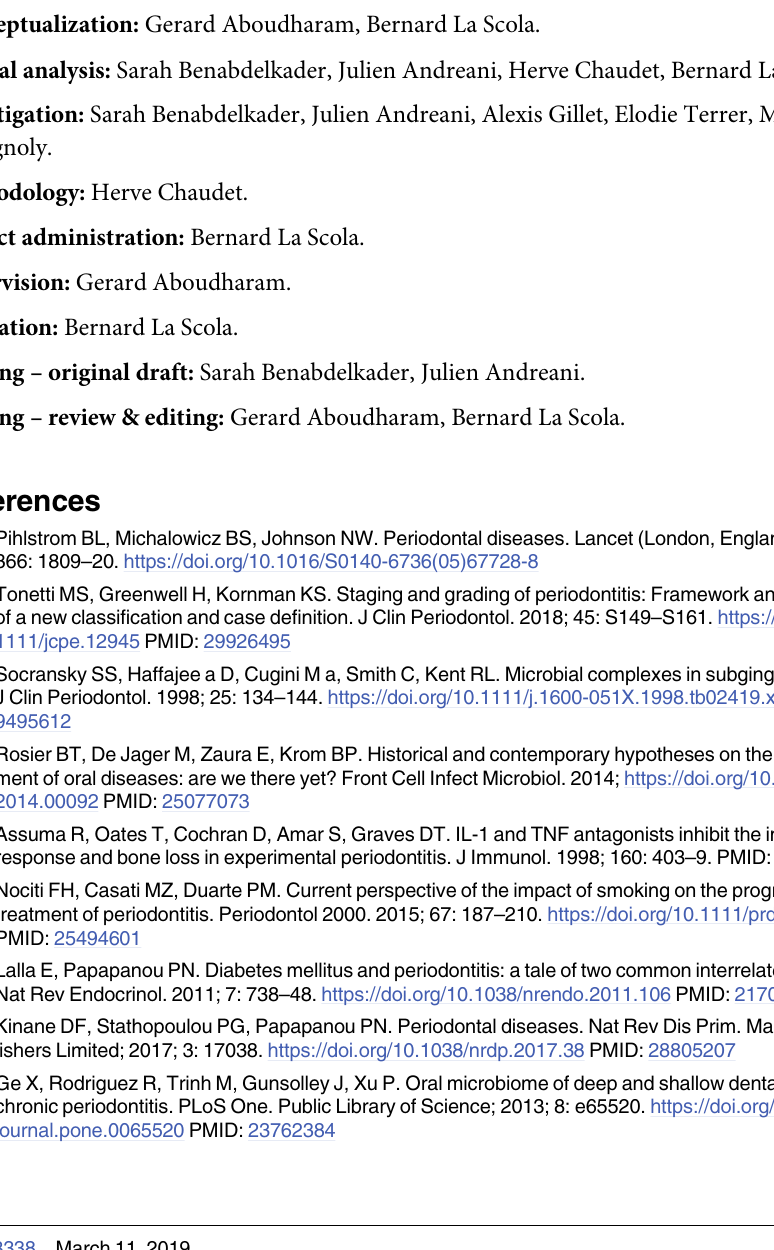
S6 Fig. Trichomonas tenax phylogenetic analysis based on Histidyl tRNA synthetase (HIST) gene. In black: patients with periodontitis. In blue: the patient controls. (TIFF) S7 Fig. Trichomonas tenax phylogenetic analysis based on Cysteinyl tRNA synthetase (CYST) gene. In black: patients with periodontitis. In blue: the patient controls.